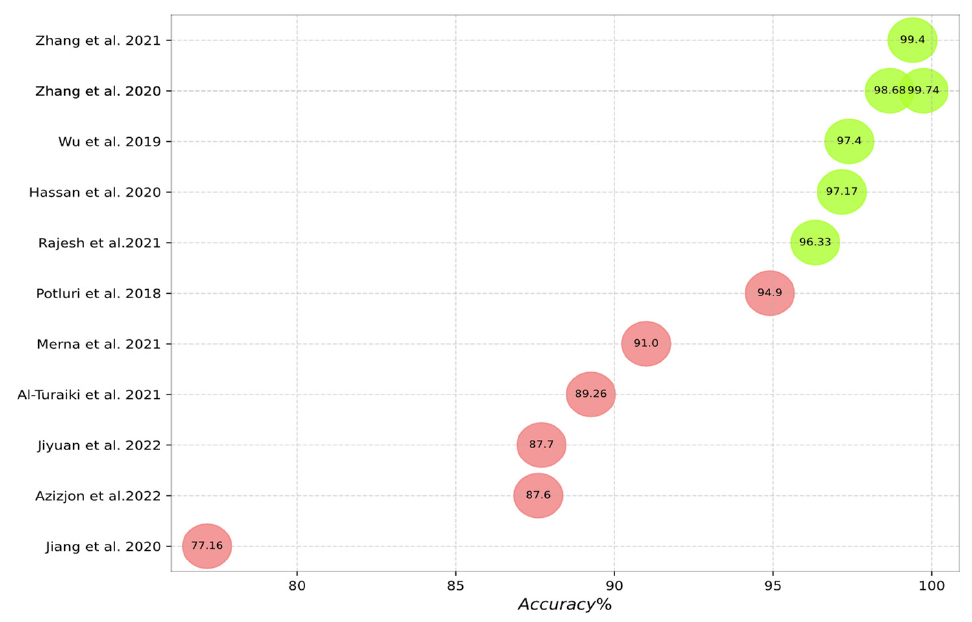
Figure 13. Accuracy of the studied schemes on the UNSW-NB15 dataset [15,16,20,37,38,42,49,59,61,